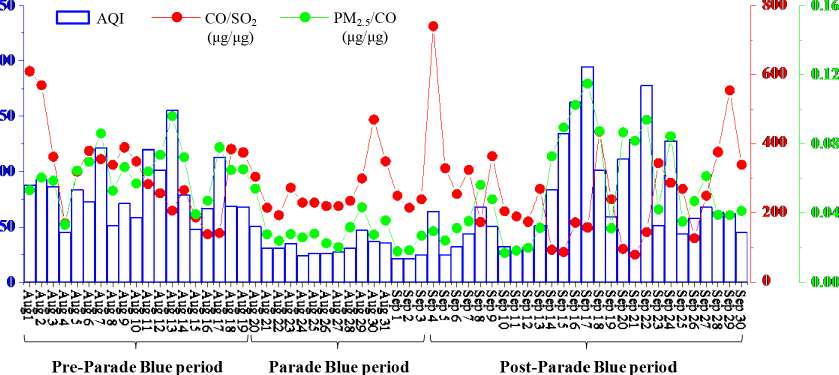
Figure 4. Daily values of AQI and daily ratios of CO to SO 2 concentrations and of PM 2 . 5 to CO concentrations in Beijing during the pre-Parade Blue, Parade Blue and post-Parade Blue